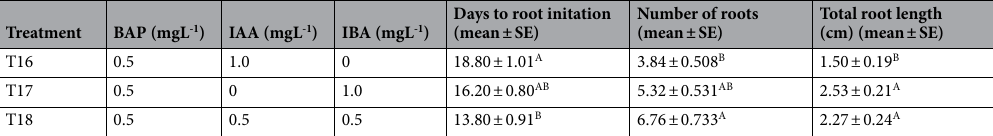
Table 5. The effect of different concentrations of IAA and IBA along with BAP on roots initiation, number of roots and total root length of S. costus . Each value represents mean ± SE of five replicates.